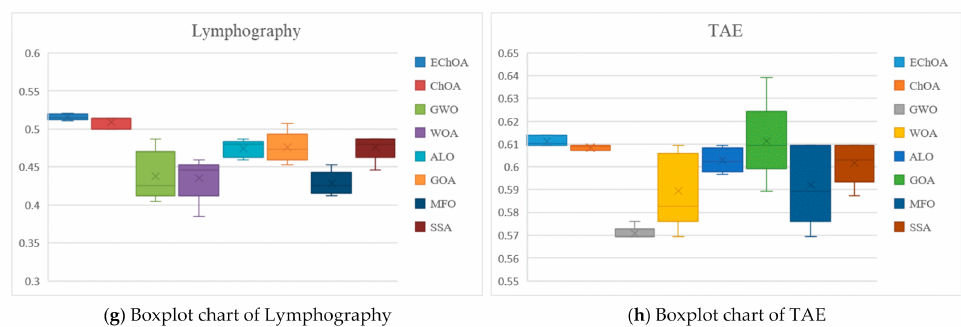
Figure 3. Boxplot charts for the accuracy of EChOA and other algorithms based on 8 data